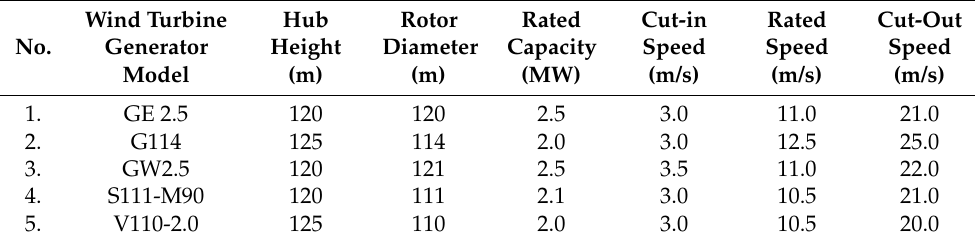
Table 2. The mechanical characteristics of the wind turbine generators used in this analysis.